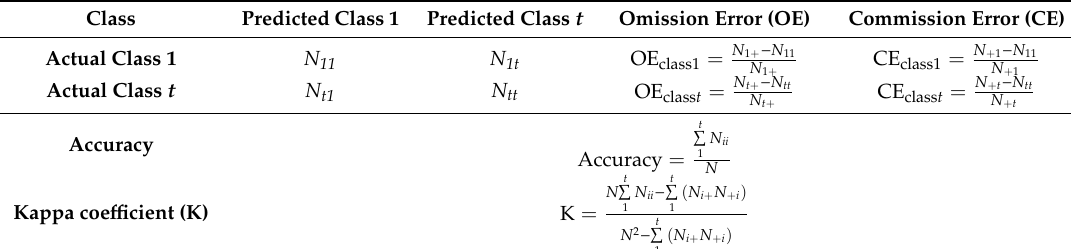
Table 5. Confusion matrix example of t classes and the formulas of accuracy, Kappa coe ffi cient, omission error, and commission